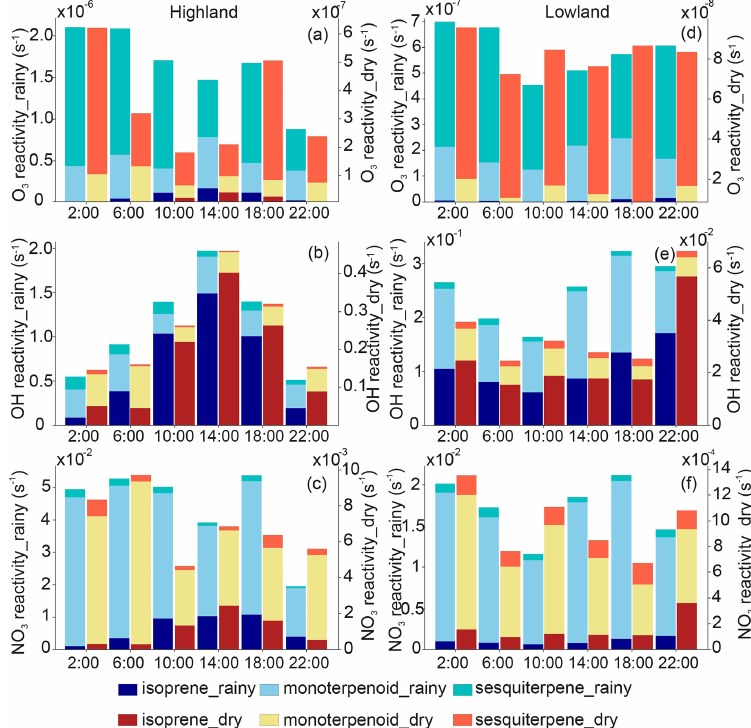
Figure 6. Reactivity of ozone (O 3 ), hydroxyl (OH), and nitrate (NO 3 ) of different biogenic volatile organic compounds in the high- land (a, b, c) and lowland ecosystems (d, e, f) in the rainy and dry seasons.